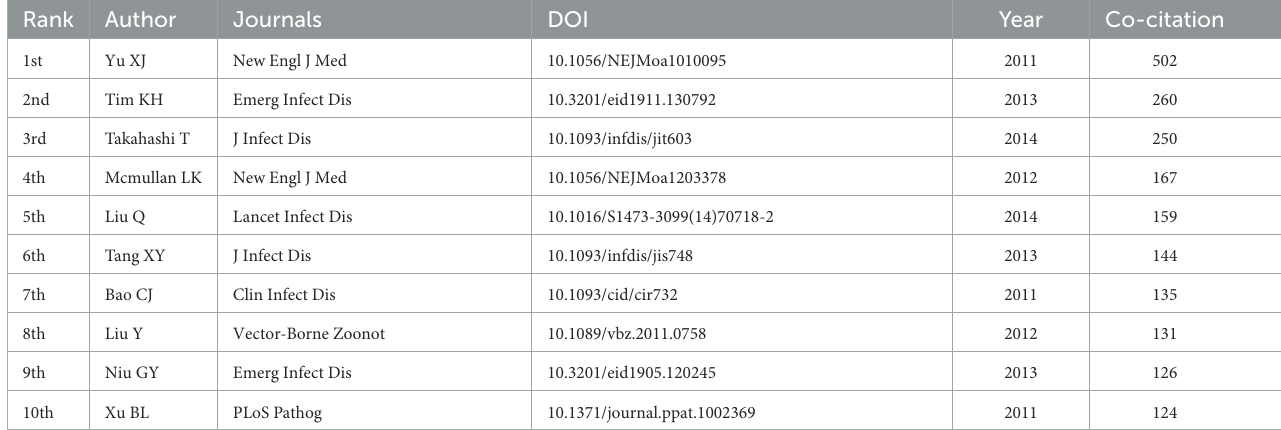
TABLE 5 The top 10 reference in number of co-citations concerning